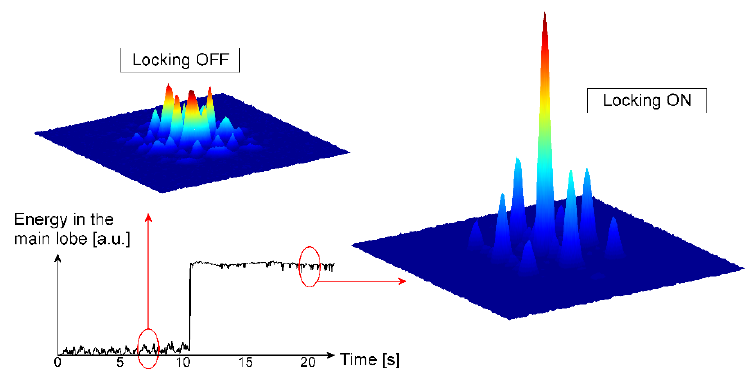
Figure 10. Experimental far field pattern of the 16 combined beams, when PLLs are off ( upper left ), and when PLLs are on ( right ). The plot shows the temporal evolution of the energy encircled in the main central lobe of the combined beam.